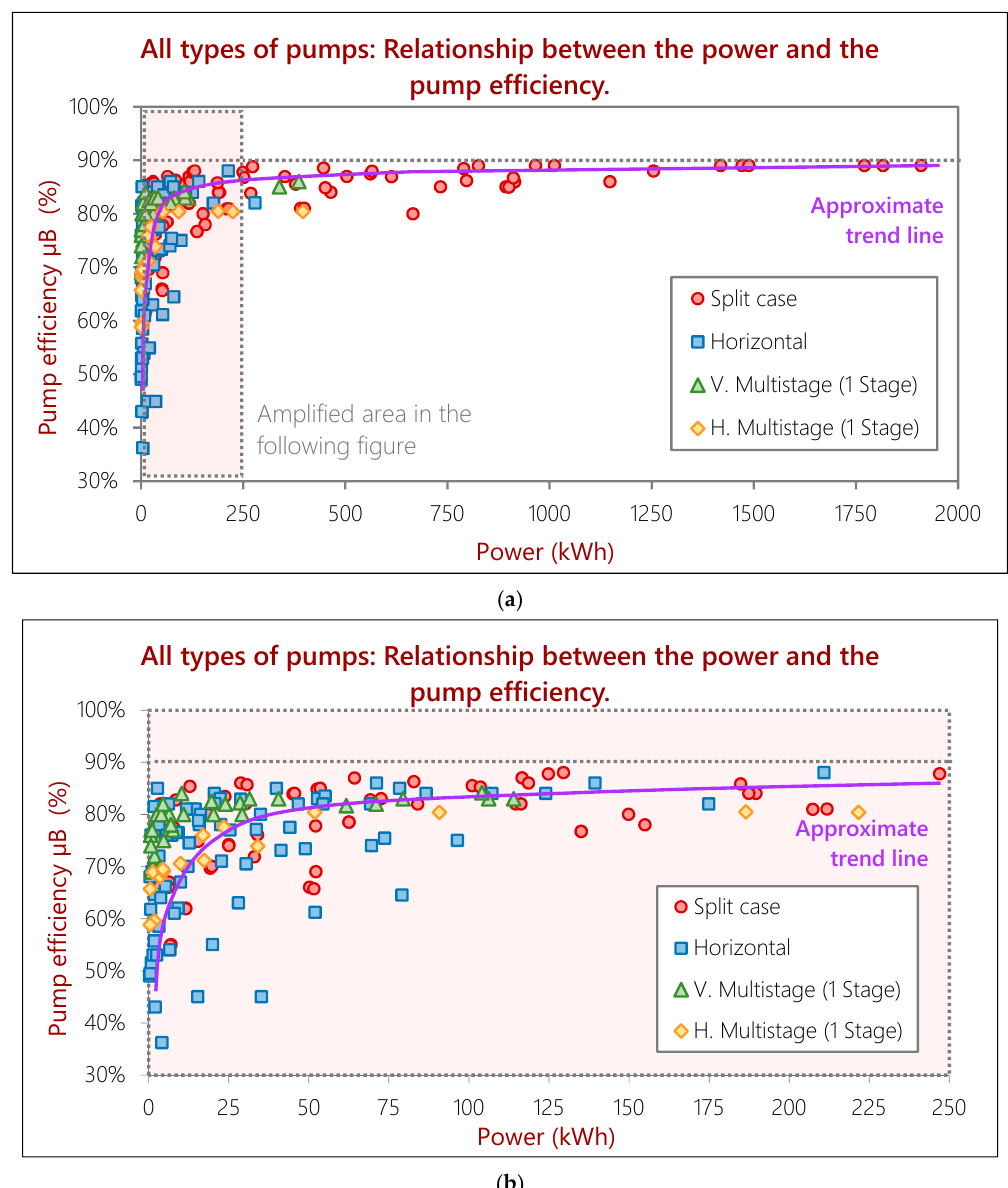
Figure 3. ( a ) Optimum pump efficiency and the correspondent pump power at that operating point. ( b ) Detail of the previous figure.